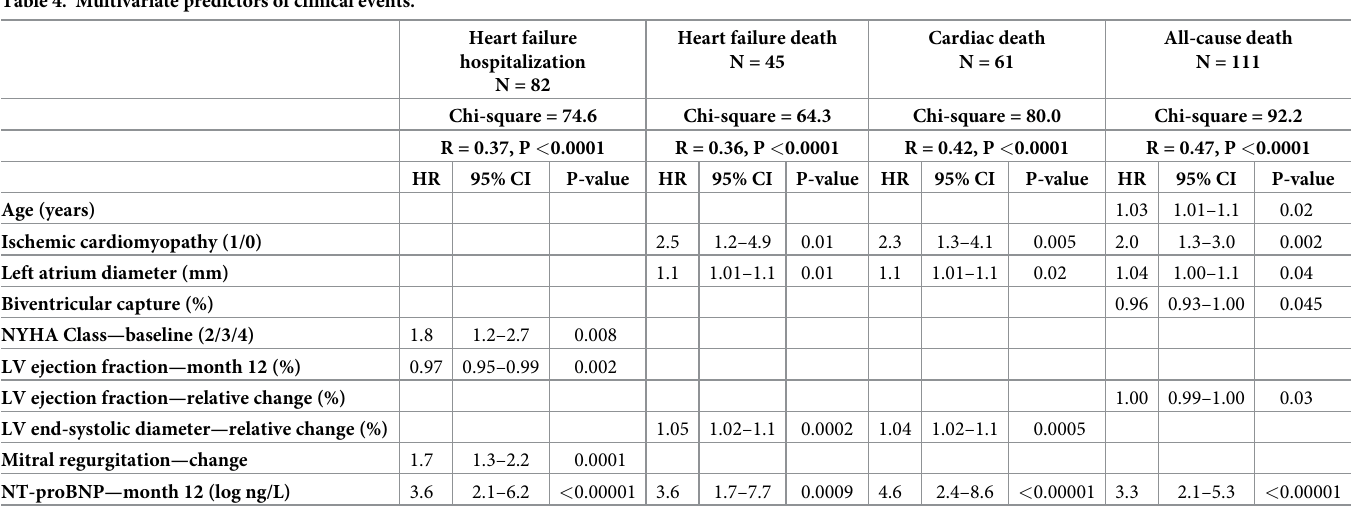
Table 4. Multivariate predictors of clinical events.